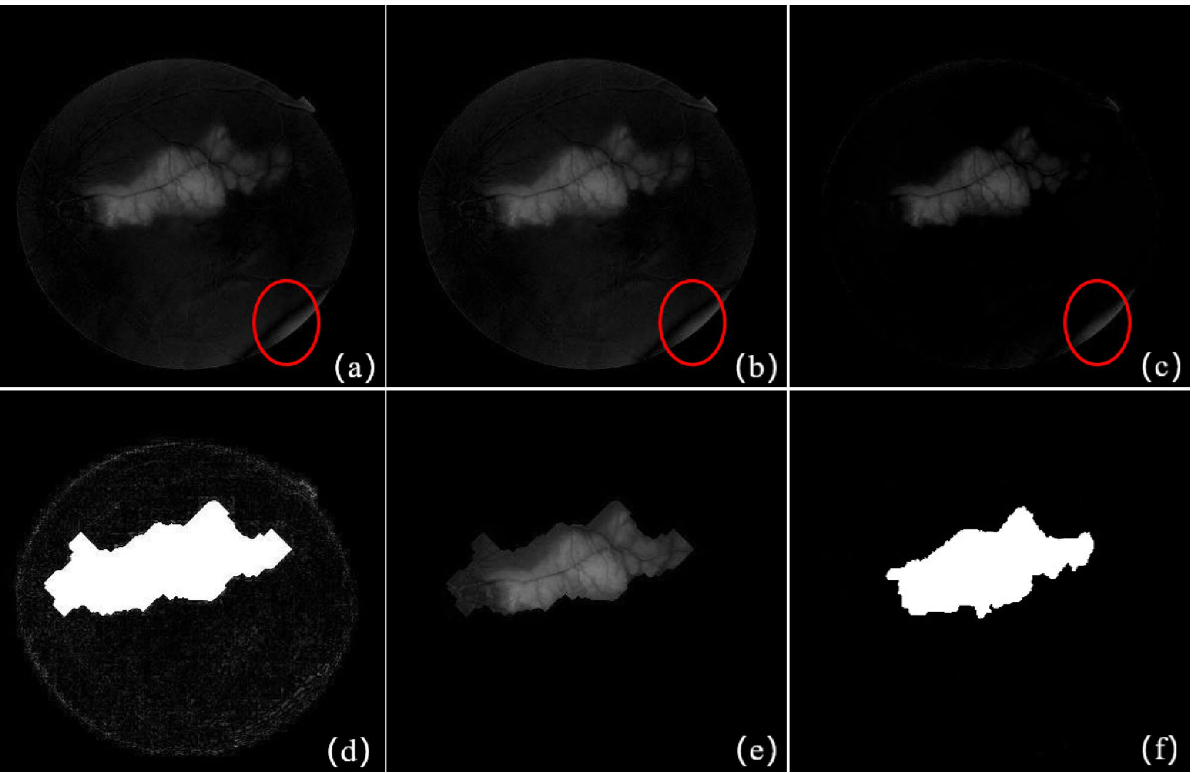
Figure 7. The result of the pair of images with large lesions in Fig. 6. ( a ) Result of global difference method; ( b ) difference image with IRHSF correction; ( c ) result of RPCA method; ( d ) change area mask of interest; ( e ) result fusing IRHSF and SRC; ( f ) the